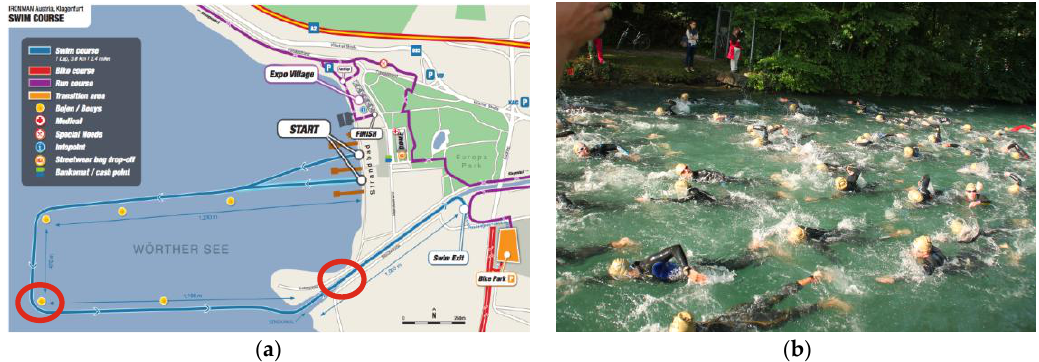
Figure 1. ( a ) Map of the swimming course at the Ironman Austria (3800 m) with two preferred positions for placing a timing system; ( b ) During the last 800 m the swimmers have to pass a narrow channel. Here a water timing station can be used for pre-announcing the athletes at the swim finish.